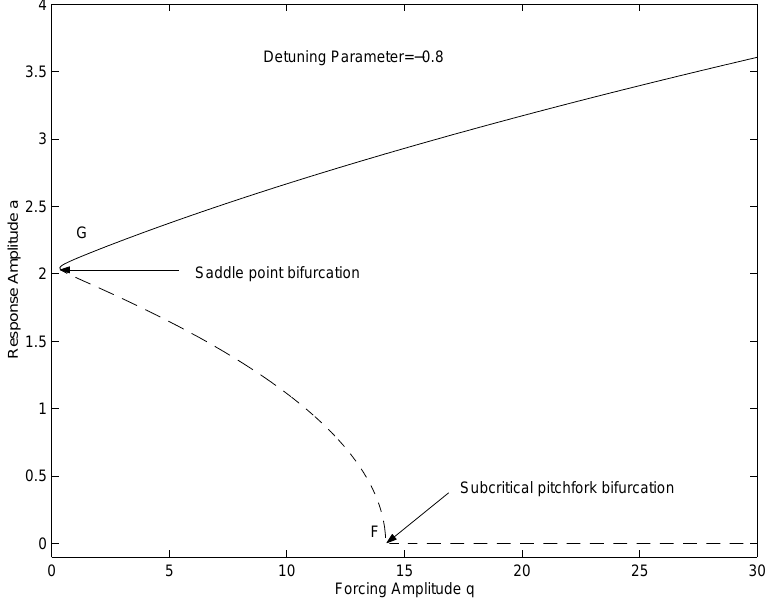
Fig. 4. Variation of the steady-state response amplitude with the forcing amplitude for negative detuning